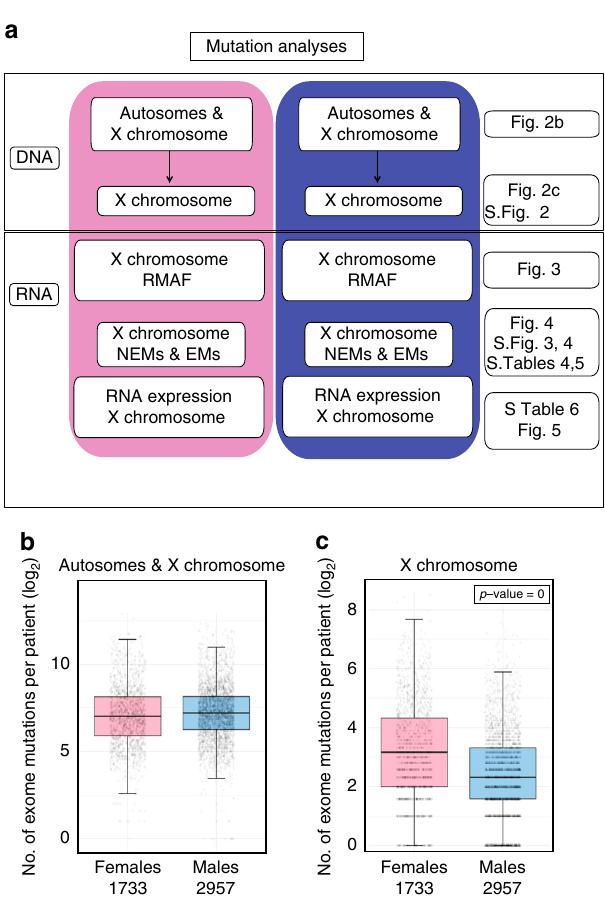
Fig. 2 Frequency of X-chromosome mutation was greater in females than males for the 12 disparity cancers. a The scheme shows our strategy for bioinformatic data analyses of exome mutations, their expression and overall mRNA content analyses in TCGA data sets; with corresponding fi gure identity listed on the right. On a per patient basis, ( b ) the number of exome mutations in the autosomes and X chromosomes and the ( c ) number of exome mutations for the X chromosome alone are presented (and importantly this collective data aligns with the individual cancers as evident in Supplementary Fig. 2a, b). Females are indicated in pink and males in blue. These are standard boxplots with the median as the centre line across the boxed-in upper and lower quartiles, with maximum and minimum values demarcated by whiskers.